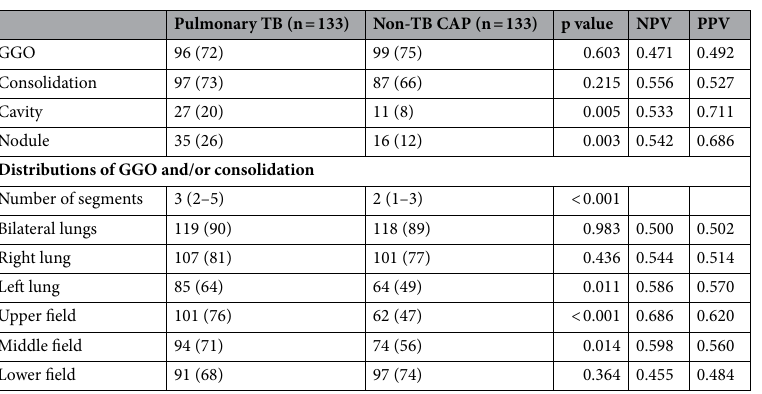
Table 2. Chest X-ray features of elderly patients with pulmonary tuberculosis and those with non-tuberculosis CAP. Data are presented as number (%). CAP community-acquired pneumonia, TB tuberculosis, NPV negative predictive value, PPV positive predictive value, GGO ground-glass opacities.